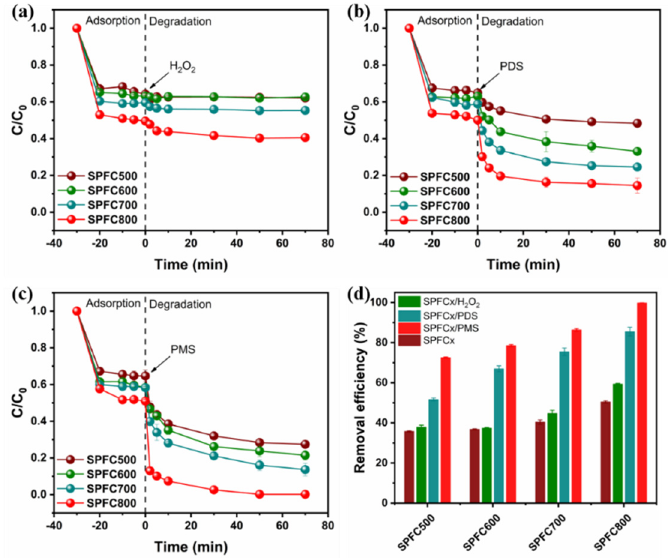
Figure 3. Catalytic degradation of BPA in SPFCx/H 2 O 2 ( a ); SPFCx/PDS ( b ); SPFCx/PMS ( c ); systems, respectively, and the removal efficiencies of BPA in various oxidation process ( d ). (Experimental conditions: [BPA] = 10 mg L − 1 , [Oxidant] = 5 mM, and [SPFCx] = 0.2 g L − 1 ).